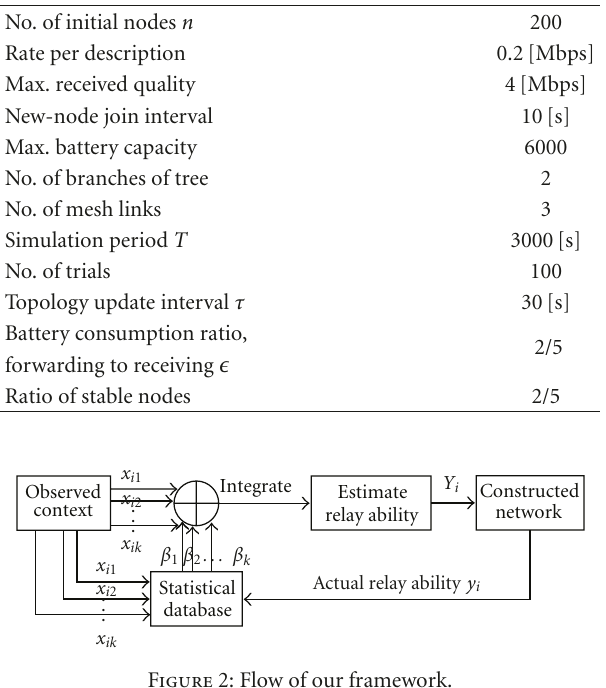
Table 1: Simulation parameters.